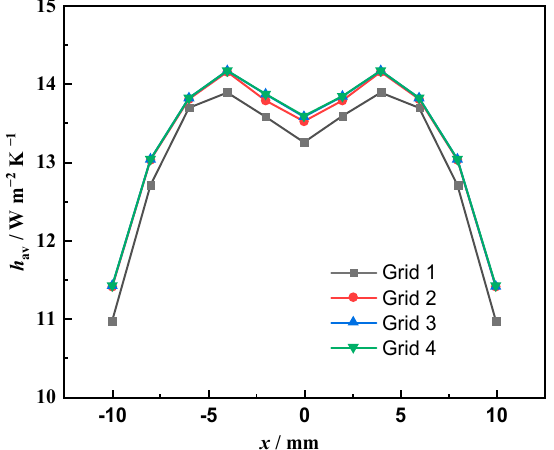
Figure 3. Grid independence validation.